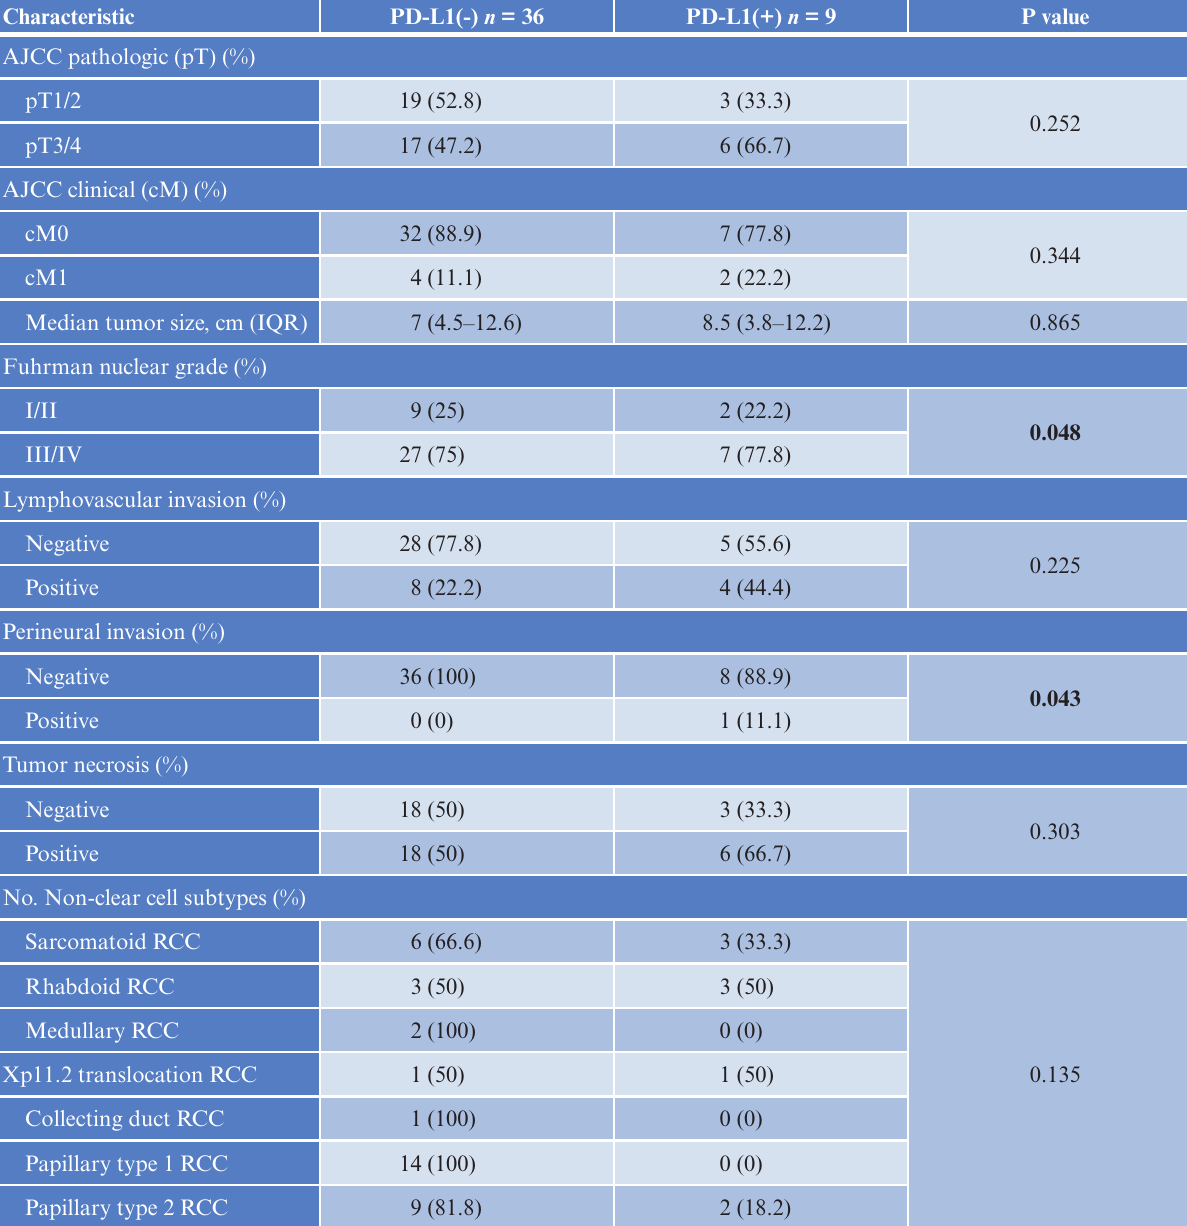
Table 2. Association of PD-L1 expression and histopathologic characteristics in non-ccRCC.